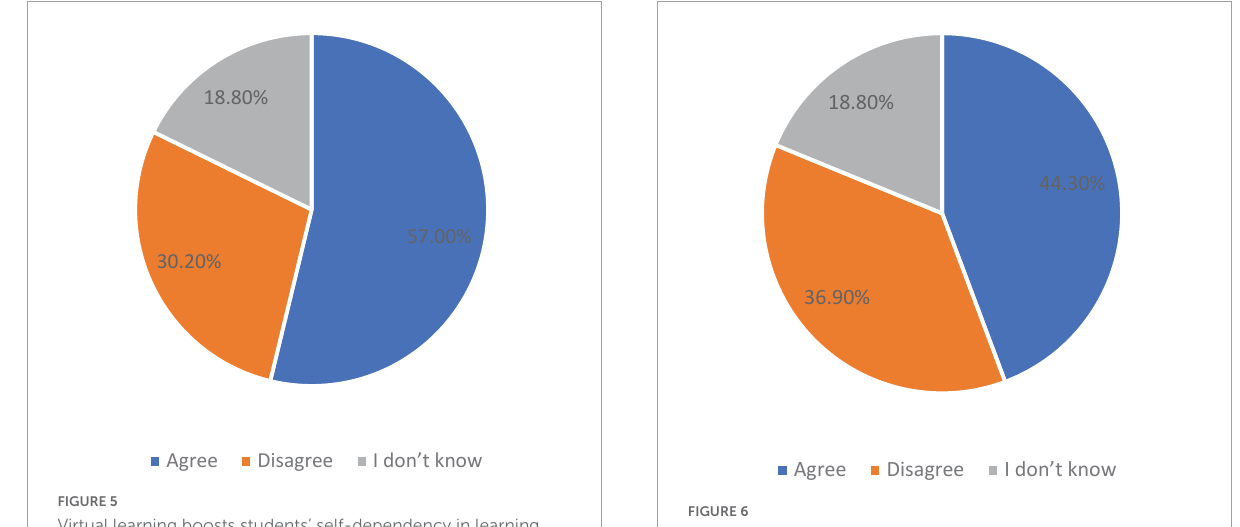
FIGURE6 Virtual learning opens new dimensions in English learning.